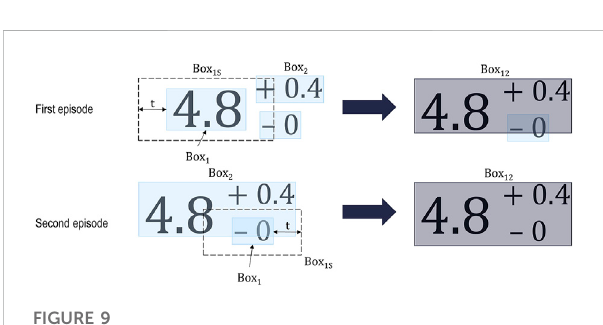
Algorithm 2: “ Fire Propagation ” Algorithm